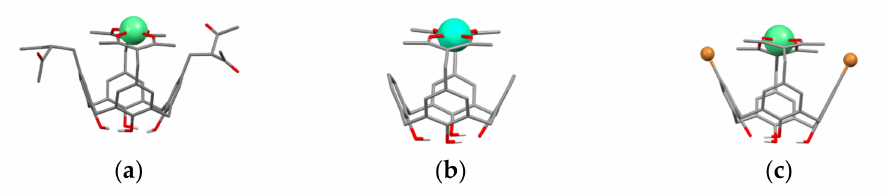
Figure 3. Bis-chelated coordination of Tb 3+ ion by tetra-1,3-diketone 27a ( a ) and bis-1,3-diketone 32a ( b ) and 37 ( c ) calix[4]arenes. The structures are obtained after SPARKLE/PM7 optimization with the use of MOPAC 2012 software. Reproduced from Ref. [54] ( a ), [59] ( c ) and redrawn from reference [55] ( b ) with permission from the Elsevier, the Centre National de la Recherche Scientifique (CNRS) and the Royal Society of